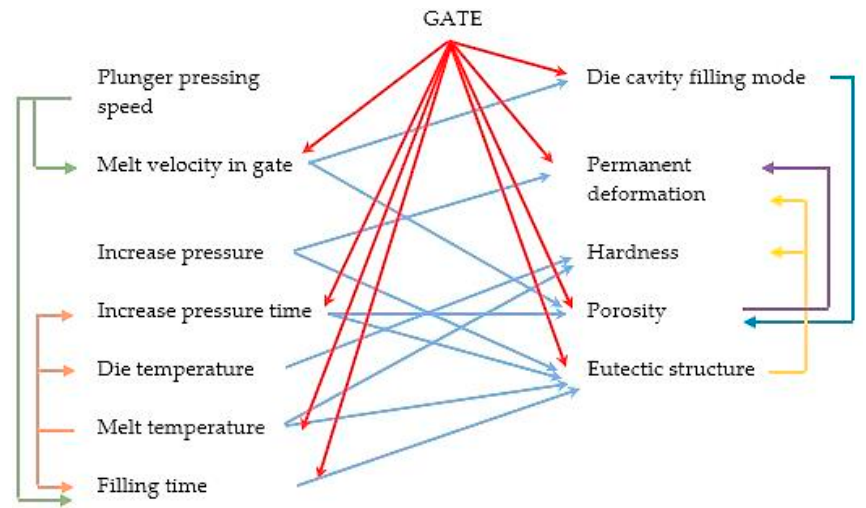
Figure 8. Mutual correlation of factors.